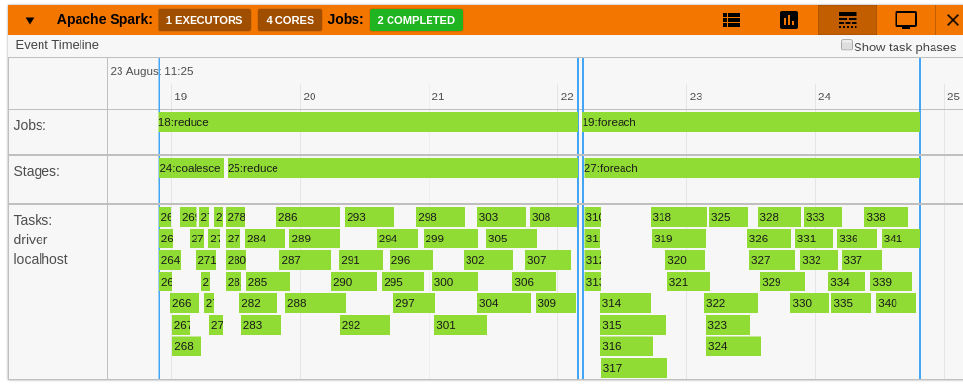
Figure 4: Visualization of status and resource utilization